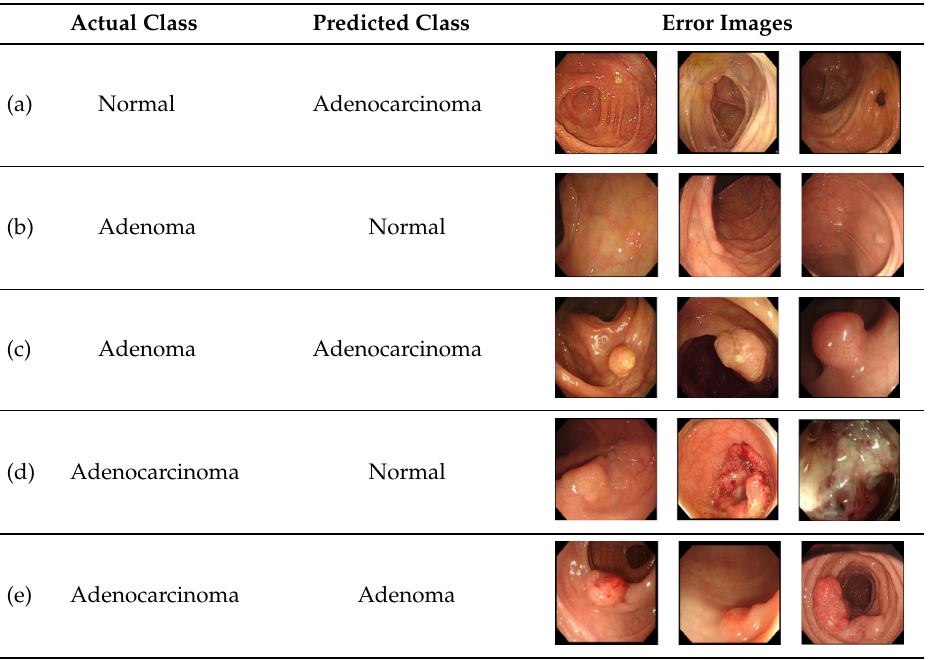
Table 7. Error images.